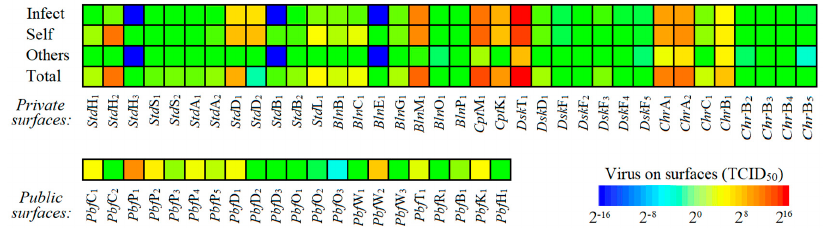
Figure 4. Quantity of virus (TCID 50 ) transmitted from various types of sub ‐ surfaces from the private surfaces of the infected student, the student’s own private surfaces, the private surfaces of other susceptible students and public surfaces to the hands (TCID 50 ). susceptible students and public surfaces to the hands (TCID 50 ).